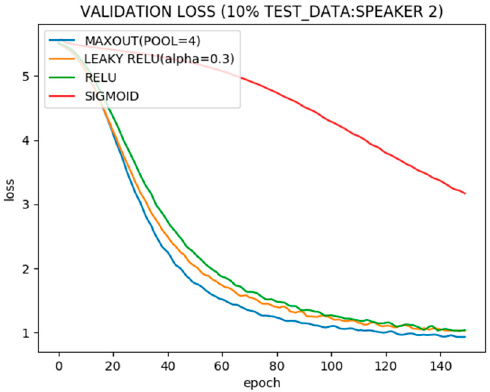
Figure 4. Test error vs. iterations for single layer activations.